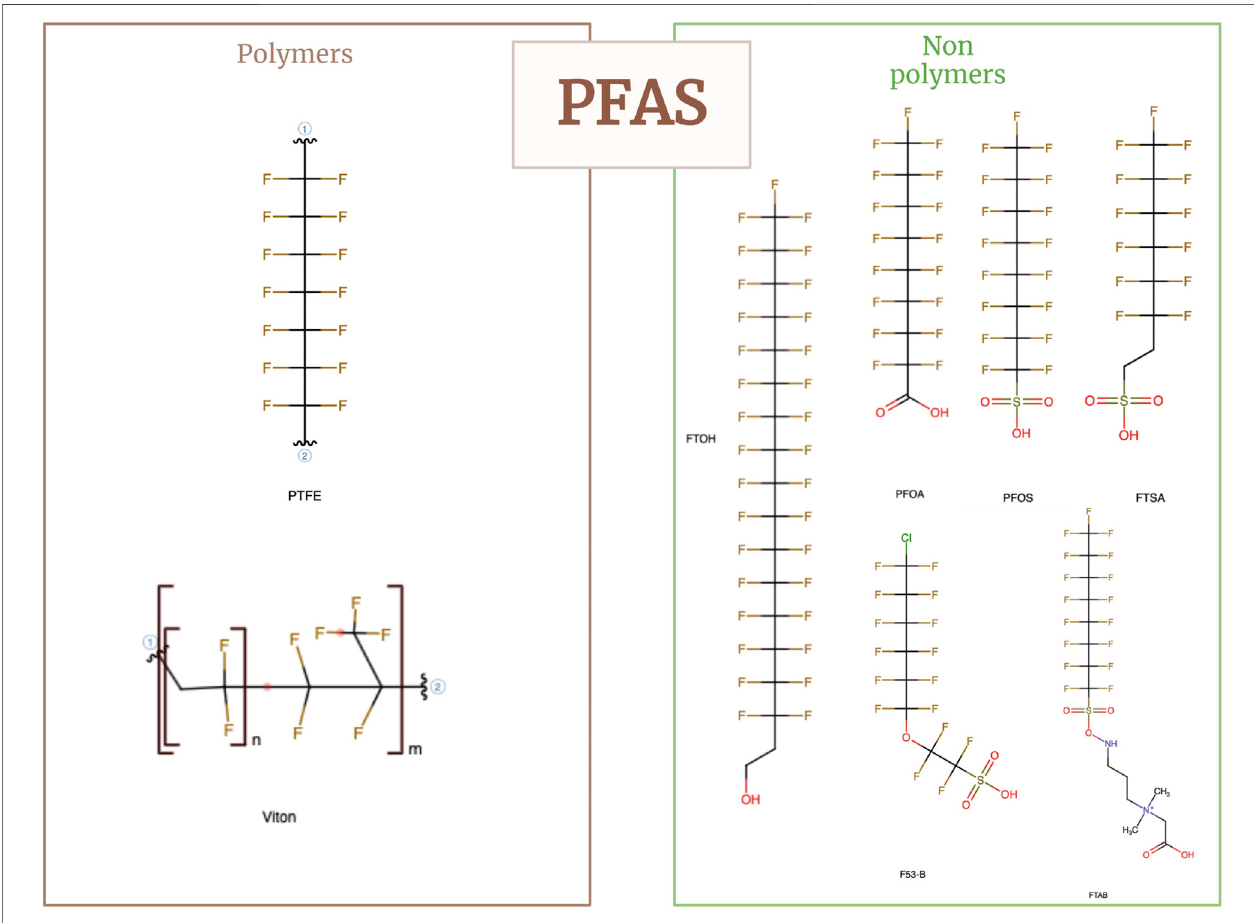
FIGURE 1 | Poly fl uoroalkyl and per fl uoroalkyl substances (PFAS), divided into polymeric and nonpolymeric compounds. Polymers include polytetra fl uoroethylene (PTFE) and Viton. Non polymers include 8:2 Fluorotelomer alcohol (FTOH), Per fl uorooctanoic acid (PFOA), Per fl uorooctanesulfonic acid (PFOS), 6:2 Flourotelomer sulfonate (FTSA), Chlorinated poly fl uorinated ether sulfonate (F53-B), and 6:2 Flourotelomer sulfonamide alkyletaine (FTAB). Created with